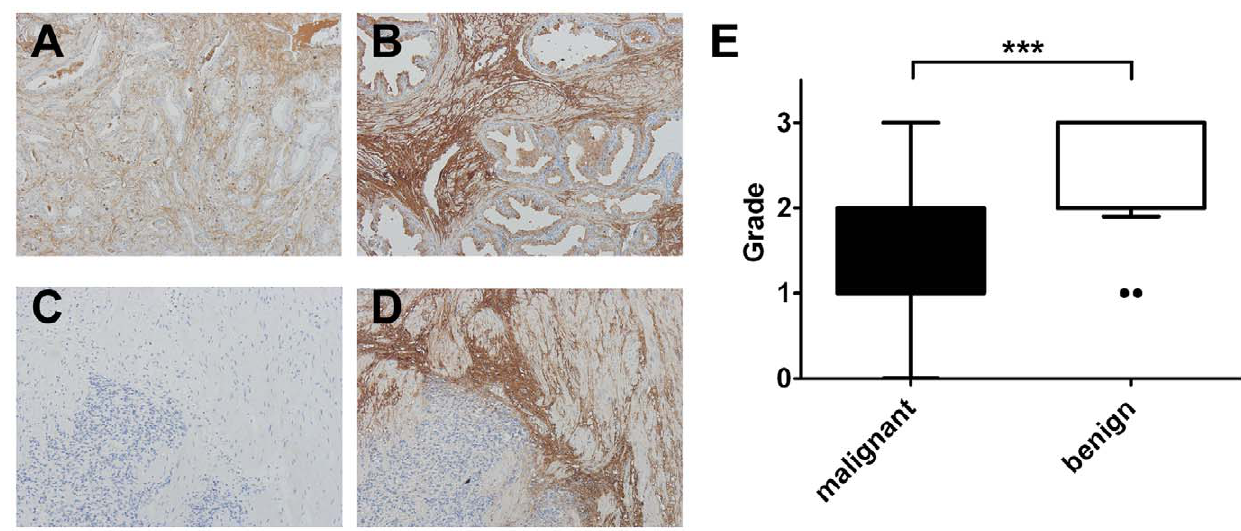
Figure 5. Decorin expression is decreased in prostate carcinomas. PCa tissue was stained via IHC for Decorin. A) A representative PCa tissue spot showed less intense staining than B) a representative non-malignant tissue spot. Simultaneously processed prostate tissue from our own tissue bank was used with non-specific IgG as negative control C) and anti-Decorin antibody as positive control (D), demonstrating specificity of staining. The evaluation of DAB staining intensity for each tissue spot is shown in E), demonstrating a significantly lower scoring in PCa (n=91) compared with non-malignant controls (n=20) (Mann Whitney test, two-tailed, p , 0.0001). The boxes indicate the 25–75 percentiles while whiskers indicate the 10– 90 percentiles.